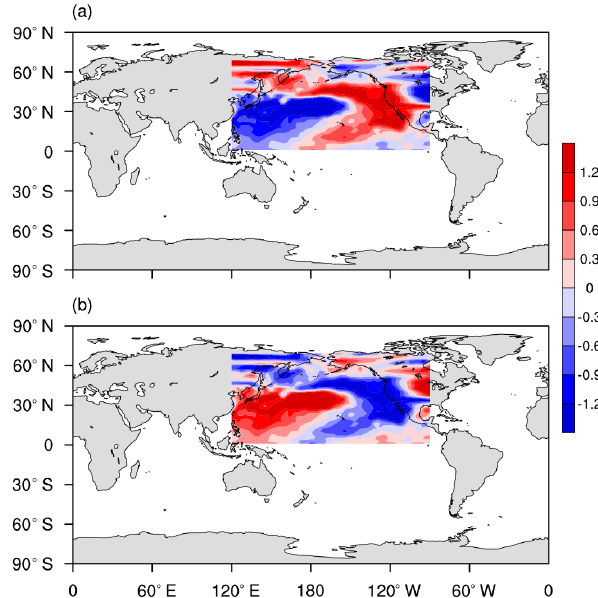
Figure 9. (a) Composite SST anomalies during negative ASO anomaly events. (b) Composite SST anomalies during positive ASO anomaly events. The ASO anomaly events are selected based on Ta- ble 2. SST data are from CESM SST forcing